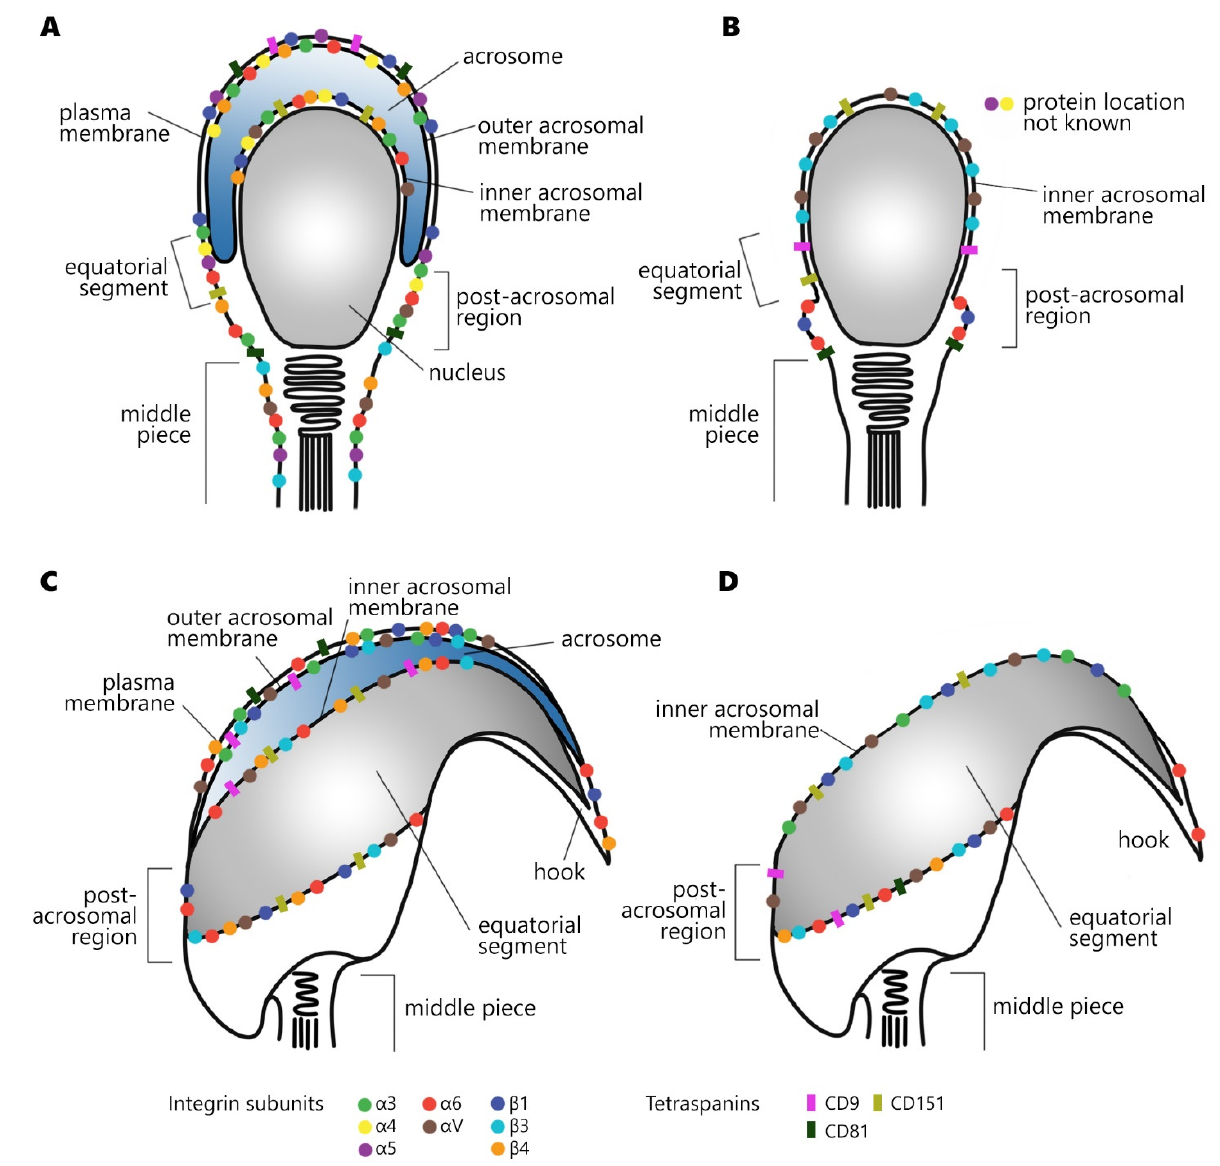
Figure 1. Localization of integrin subunits and tetraspanins in human ( A , B ), mouse ( C , D ), acrosome-intact ( A , C ), and acrosome-reacted sperm ( B , D ).